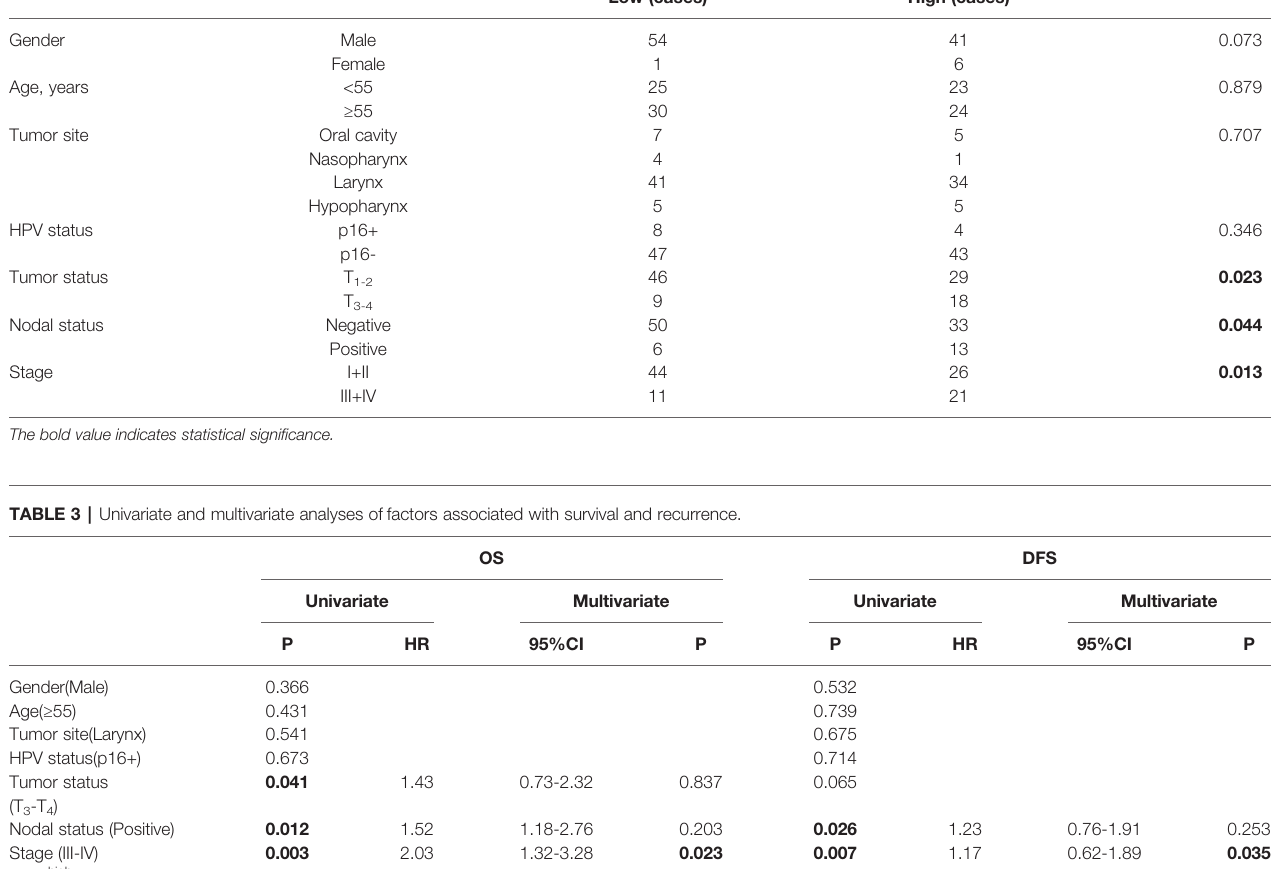
The bold value indicates statistical signi fi